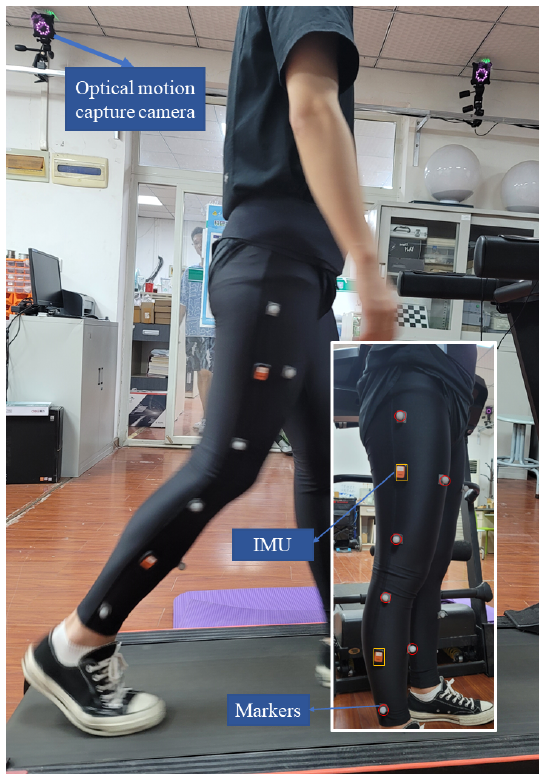
Figure 3. The experimental scenario mainly includes an optical motion capture system, IMUs and a treadmill; six markers and two IMUs are set on each leg, three markers on each segment are not co-planar and the direction of IMUs is not